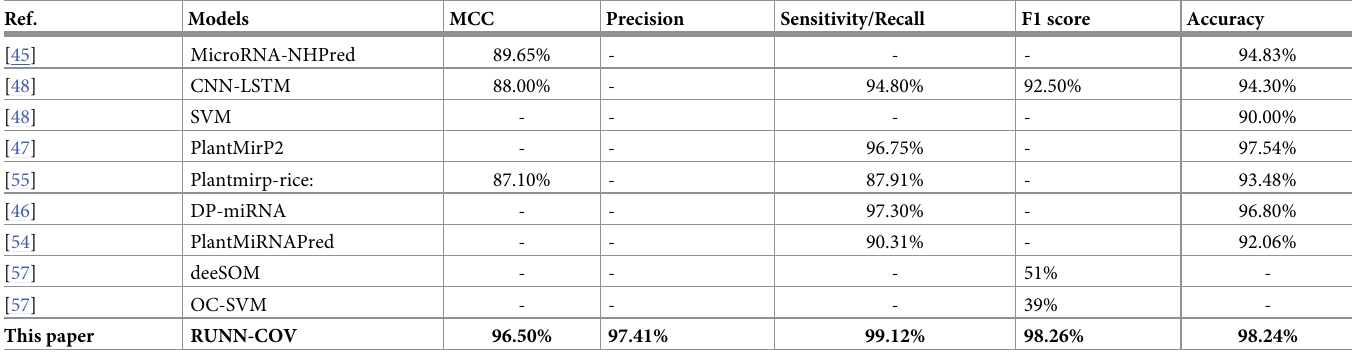
Table 3. Performance comparison proposed model with relevant existing approaches.